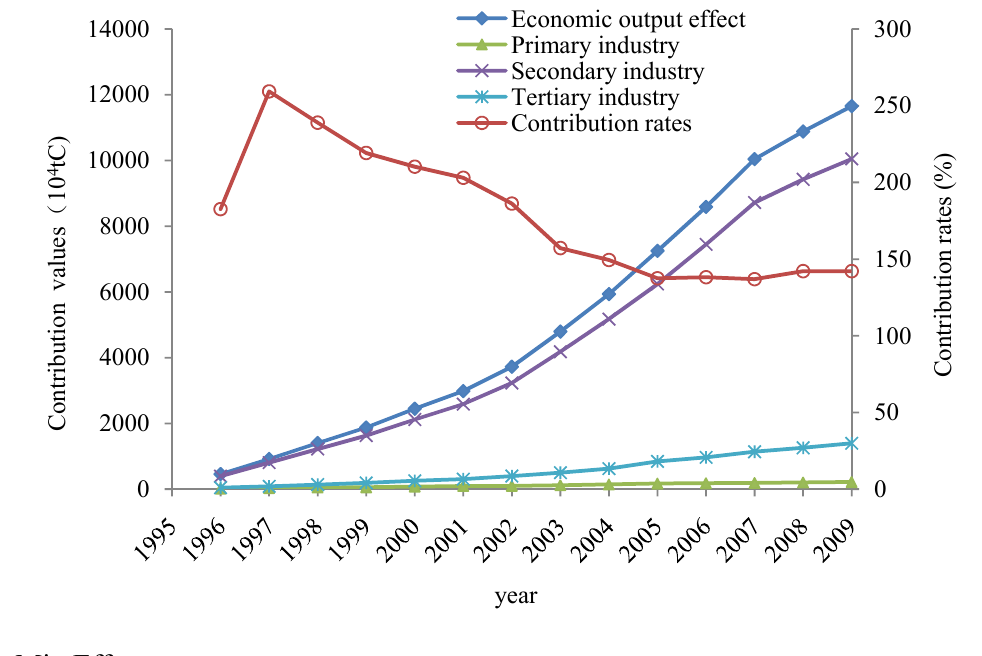
Figure 6. The contribution of economic output effect from 1996 to